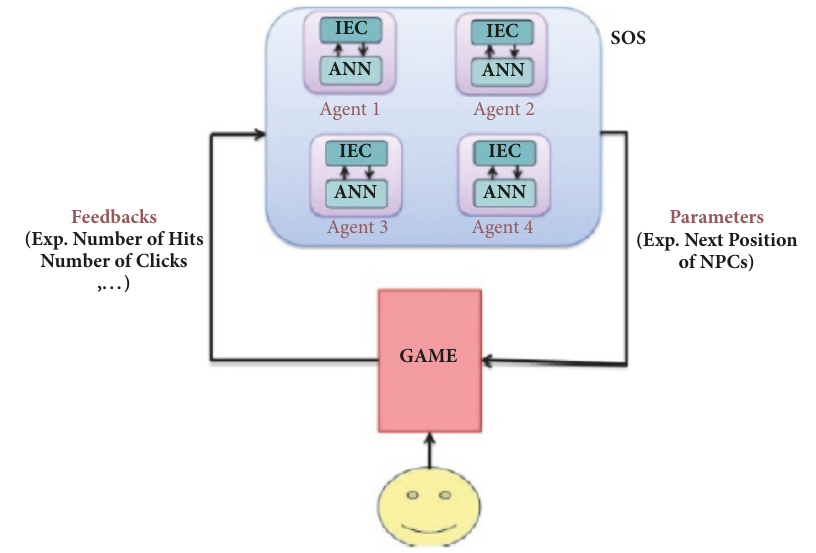
Figure 10: Illustration of self-organizing